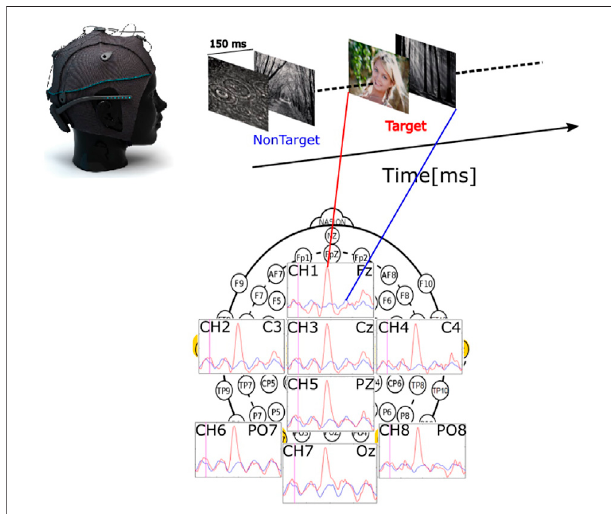
FIGURE 3 | Schematic overview of the stimuli presentation with an example response averaged over the training trials of one subject with regard to electrode placement. The evoked potential is drawn in red for the target stimulus and blue for the non-target